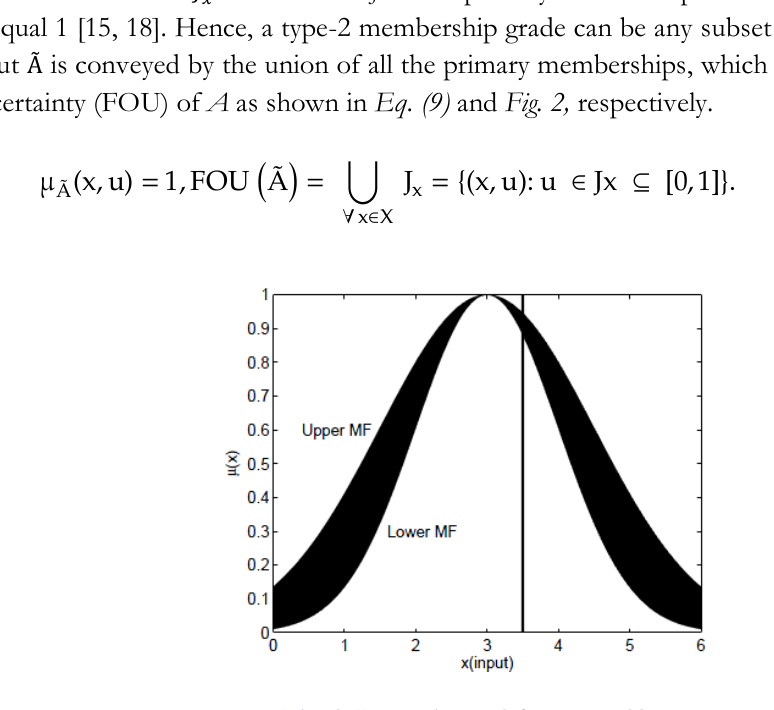
Fig. 2. Interval type-2 fuzzy set